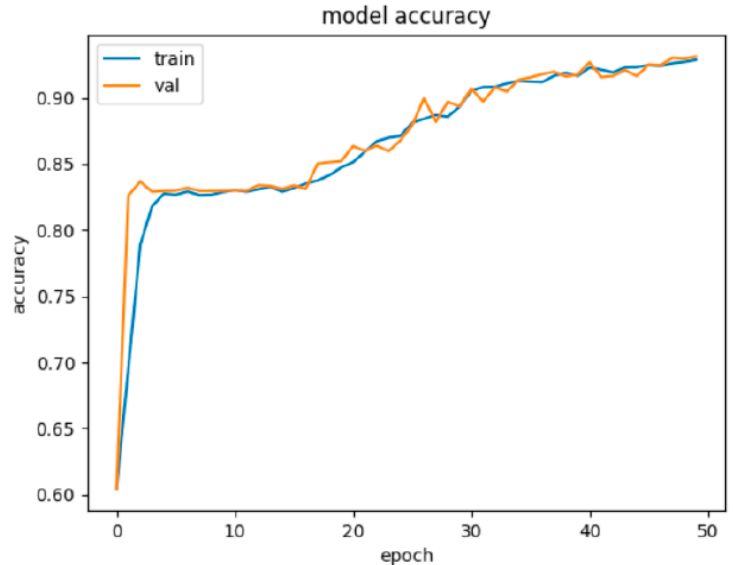
Figure 3. Graphic visualization of the progress of NN1 learning on the training and validation set.